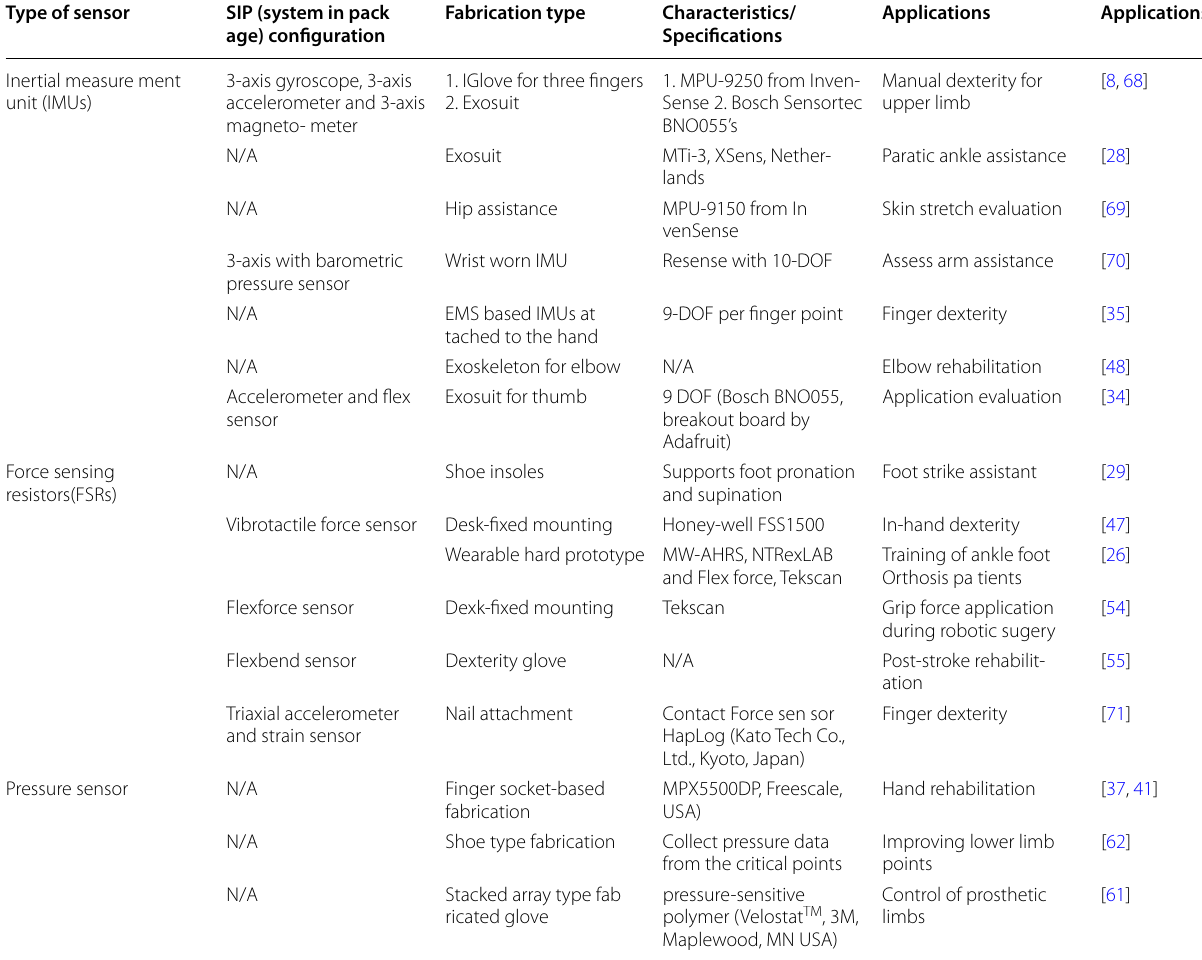
Table 3 Summary on the sensors utilization during dexterity simulation‑based training Type of